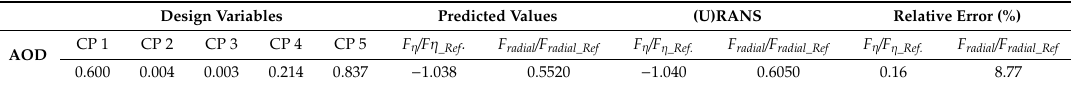
Figure 10. Pareto-optimal solutions. Table 3. Results of optimization.